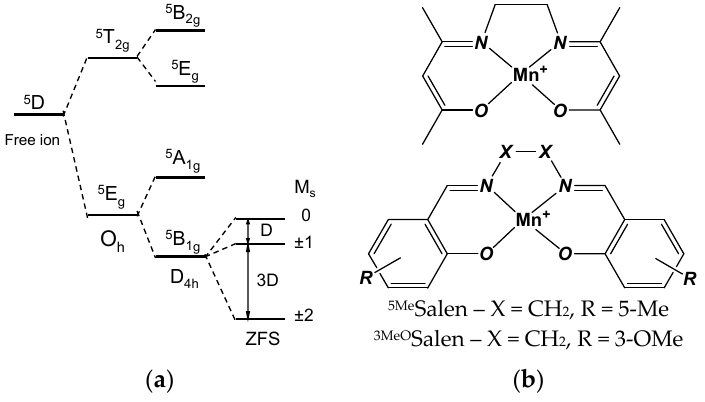
Scheme 1. ( a ) Splitting of the 5 D term by octahedral (O h ) and tetragonal (axial elongation, D 4h ) fields and by zero-field splitting; ( b ) Quadridentate environment of Mn(III) by Schiff base ligands: acacen (top) or salen ( N , N ′ -ethylene-bis(salicylideneiminate) (bottom), see text.